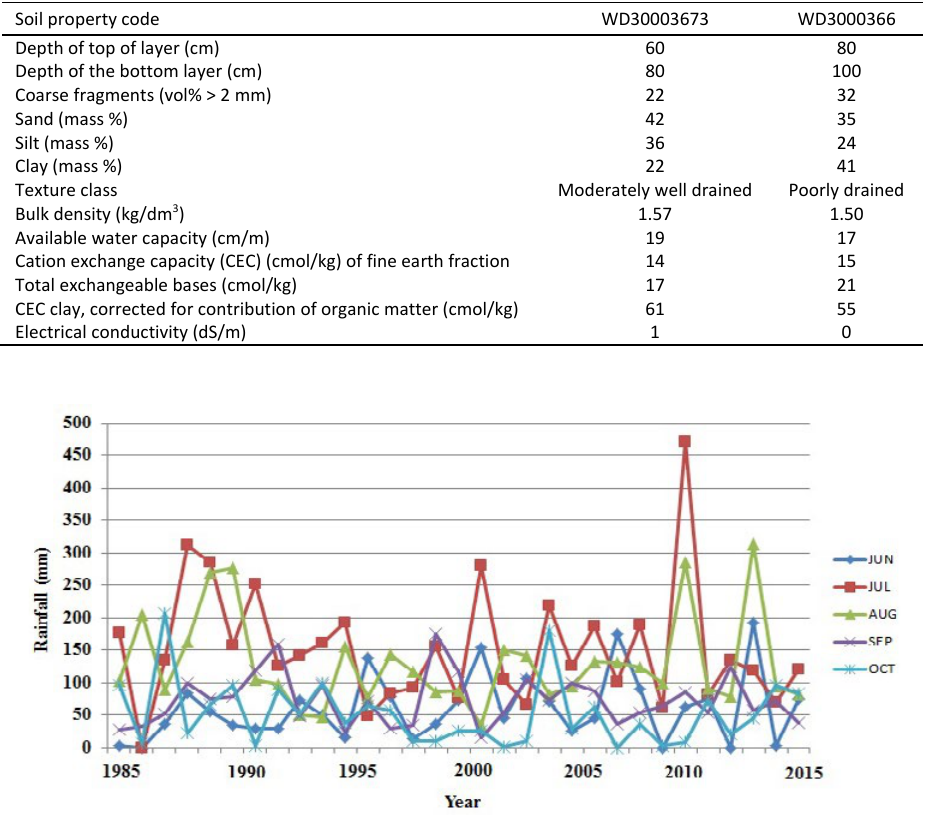
Fig. 4: Temporal rainfall of study area Fig. 4. Temporal rainfall of study